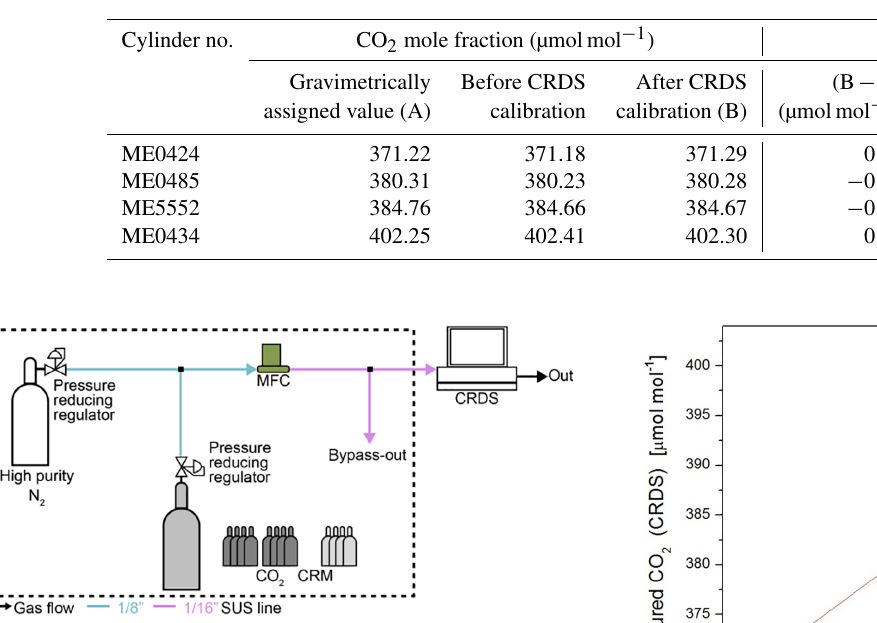
Figure 1. Schematic diagram depicting the gas supply to the WS- CRDS analyzer. The acronym SUS represents the stainless steel.